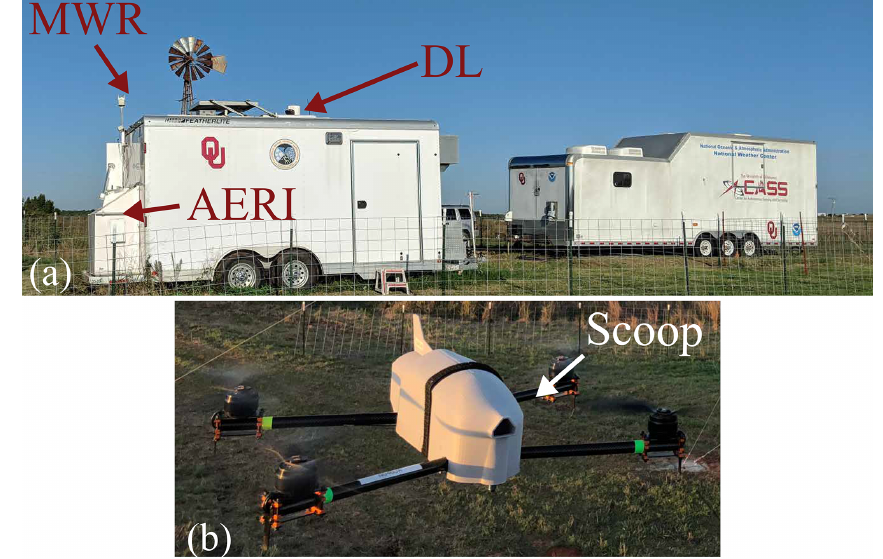
Figure 1. Photos of the CLAMPS facility ( a ) and the CopterSonde 2.5 (b) deployed at